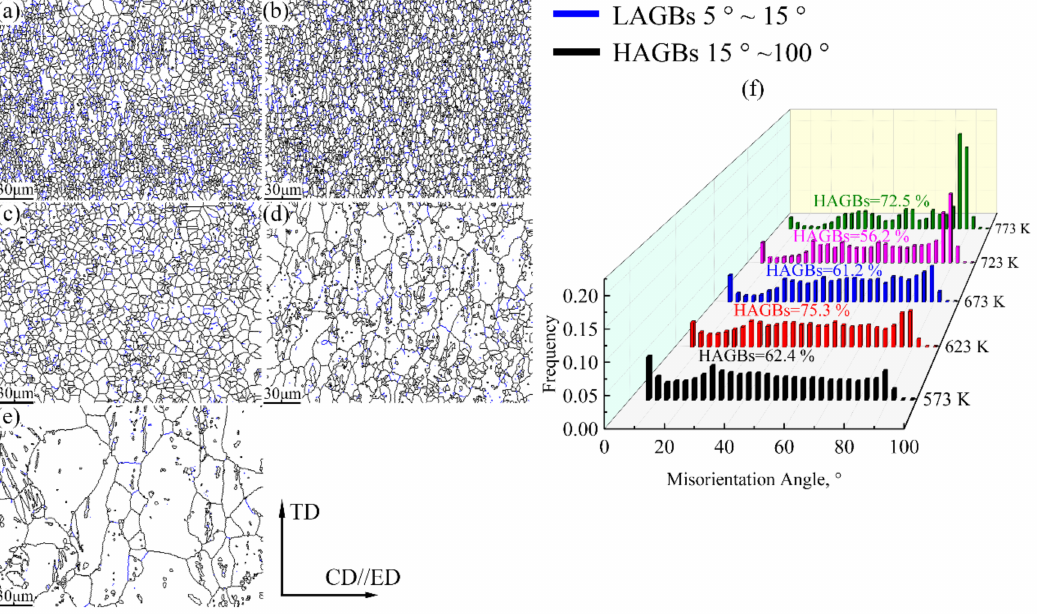
Figure 12. Grain boundary maps of the Mg-2.5Nd-0.5Zn-0.5Zr alloy deformed at different tempera- tures and a strain rate of 0.001 s − 1 . Black lines refer to HAGBs (>15 ◦ ), blue lines to LAGBs (5~15 ◦ ),